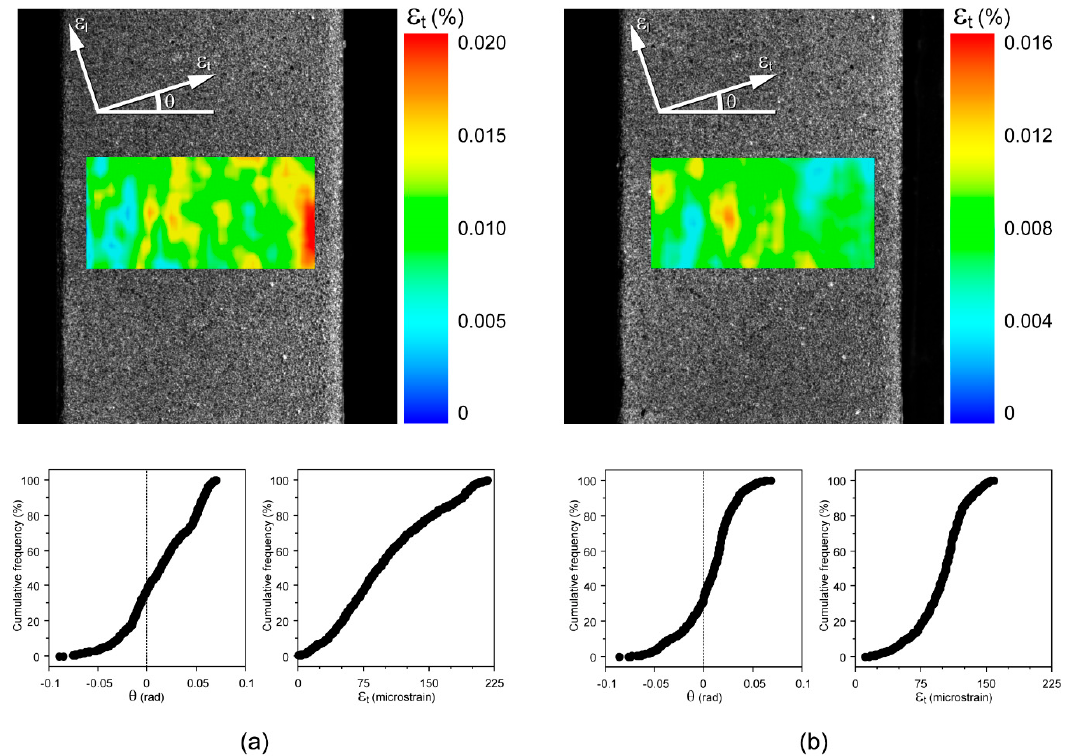
Figure 4. Two strain maps, with a cumulative distribution of θ and ε t values, calculated for the same ε l value ( ε l = 280 microstrain) on the same specimen surface during two different test-sessions. ( a ) 3SD θ > 0.1 rad: this image, and the image simultaneously acquired on the opposite surface of the specimen, must be discarded; ( b ) 3SD θ ≤ 0.1 rad: this image is accepted if θ distribution determined for the image simultaneously acquired on the opposite surface of the specimen fulfils the same requirement.